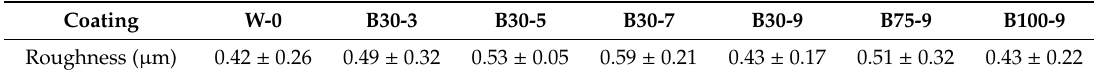
Table 3. Surface roughness of